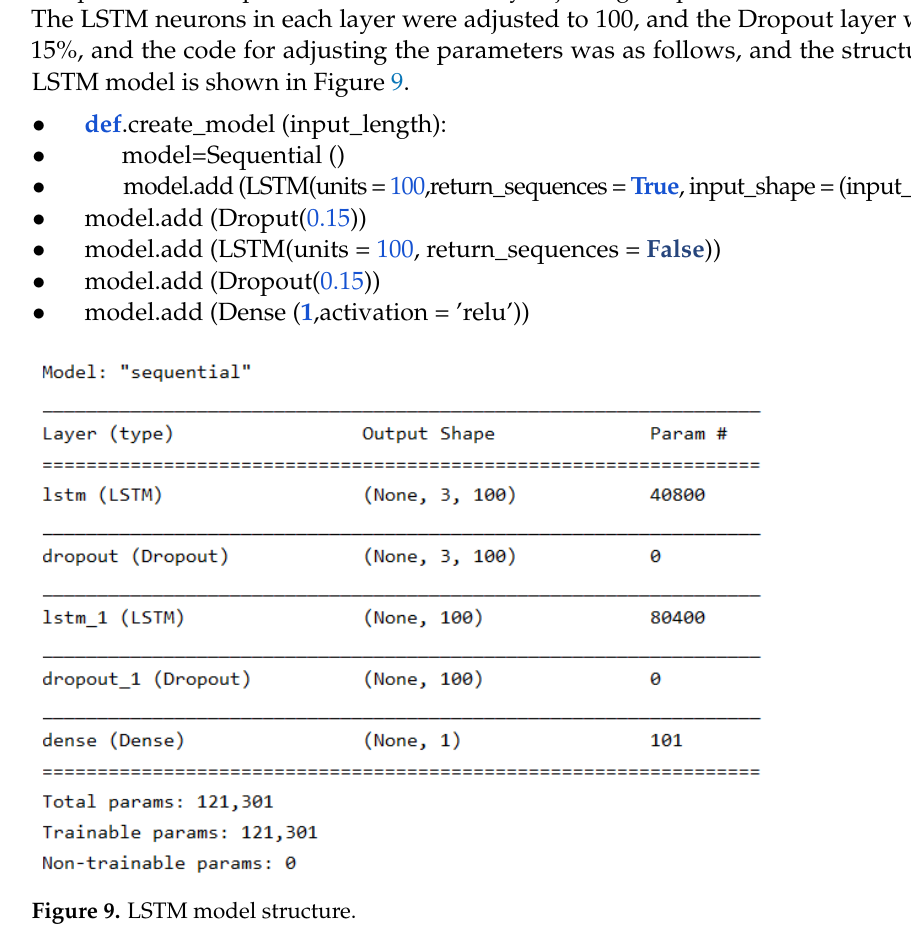
Figure 9. LSTM model